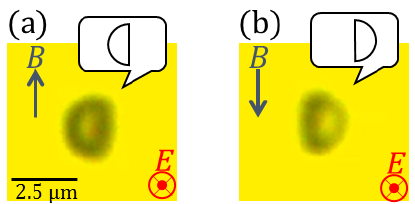
Figure 13. ( a ) When a magnetic field B is applied (parallel to the page) together with an electric field E (vertical to the page), the metal surface is oriented parallel to both electric and magnetic fields. ( b ) Reversing the magnetic field reverses the metal surface direction.